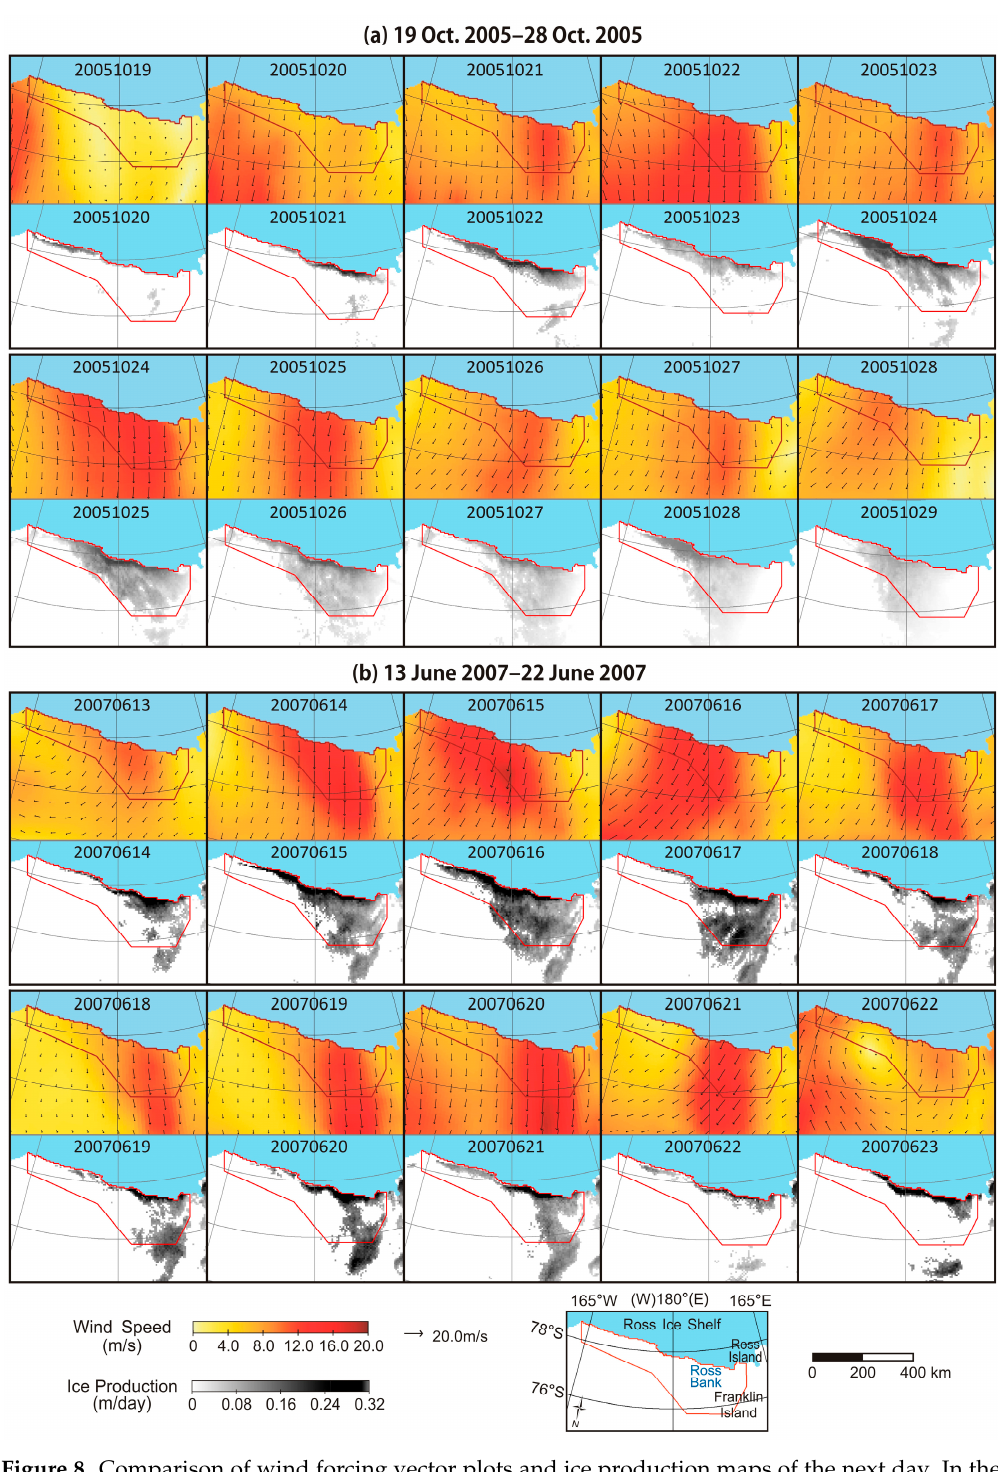
Figure 8. Comparison of wind forcing vector plots and ice production maps of the next day. In the wind forcing vector plots, the background color from yellow to red indicates wind speed from low to high. The arrows mark the wind direction, and the length of the arrows indicates wind speed. The ice production maps show the area of RISP where the color, from grey to black, indicates the ice production rate. Two extreme wind events lasting 10 days are shown in October 2005 ( a ) and June 2007 ( b ). At some dates the polynya area extends beyond the study area, which encloses the area with a polynya occurrence frequency >10% and excludes open